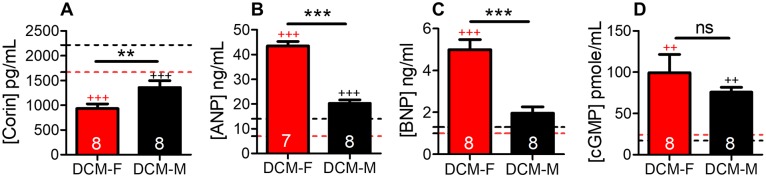
Natriuretic peptide activation in female mice.Plasma levels of (A) corin (B) ANP (C) BNP and (D) cGMP in DCM and WT, female and male mice, at 13 weeks, determined by ELISA, data represent mean± SE. DCM female (red bar), DCM male (black bar). Data for male mice have been reported [19]. The number of DCM mice per group is indicated. Female and male base line levels were indicated by red and black dotted line respectively, n = 6–8 per group. ***P<0.001, **P<0.01 (DCM male vs. DCM female). +++P<0.001, ++P<0.01 (DCM vs. WT), ns = non significant.